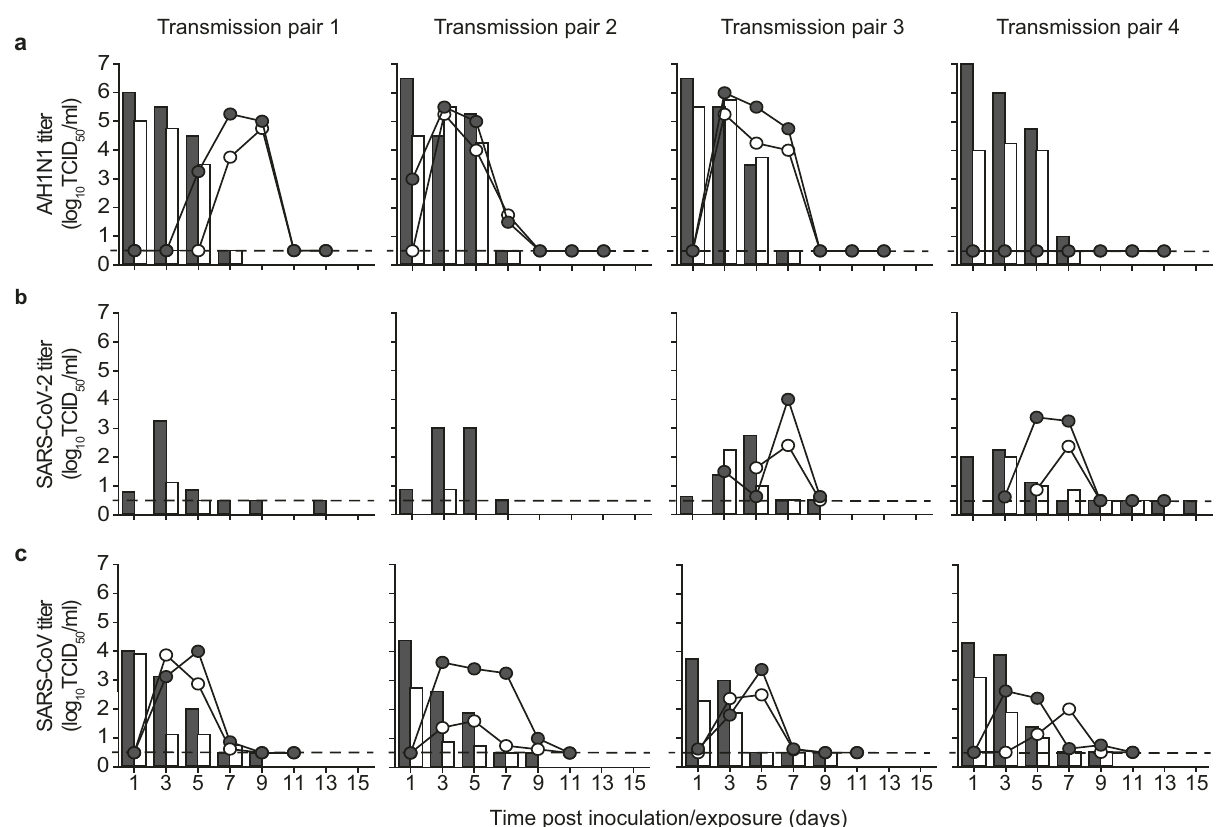
Fig. 3 Infectious virus shedding in ferrets. A/H1N1 virus ( a ), SARS-CoV-2 ( b ), and SARS-CoV ( c ) titers were detected in the throat (gray) and nasal (white) swabs collected from inoculated donor (bars) and indirect recipient (circles) ferrets. An individual donor-recipient pair is shown in each panel. The dotted line indicates the detection limit.